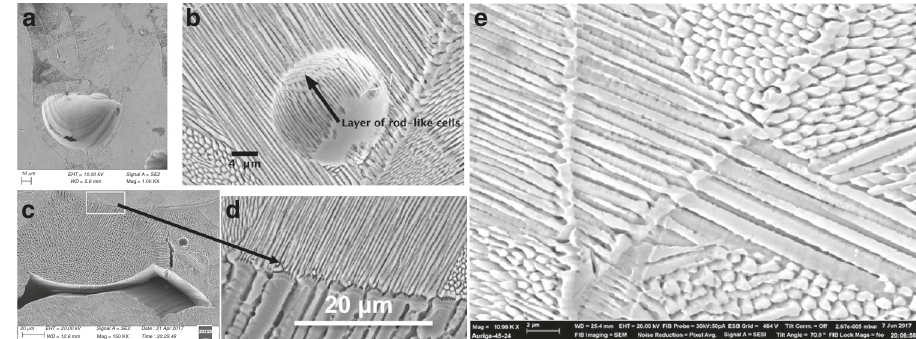
Fig. 3 Porosity and solidi fi cation microstructure in AM 316L. a Keyhole pore. b Layers of fi ne cells in a region containing a fi ne spherical entrapped gas pore. c Solidi fi cation microstructure surrounding a lack-of-fusion pore. d Zoom-in region on the centre top of c showing a sharp change in cell spacing. e Cell re fi nement occurred twice at two consecutive